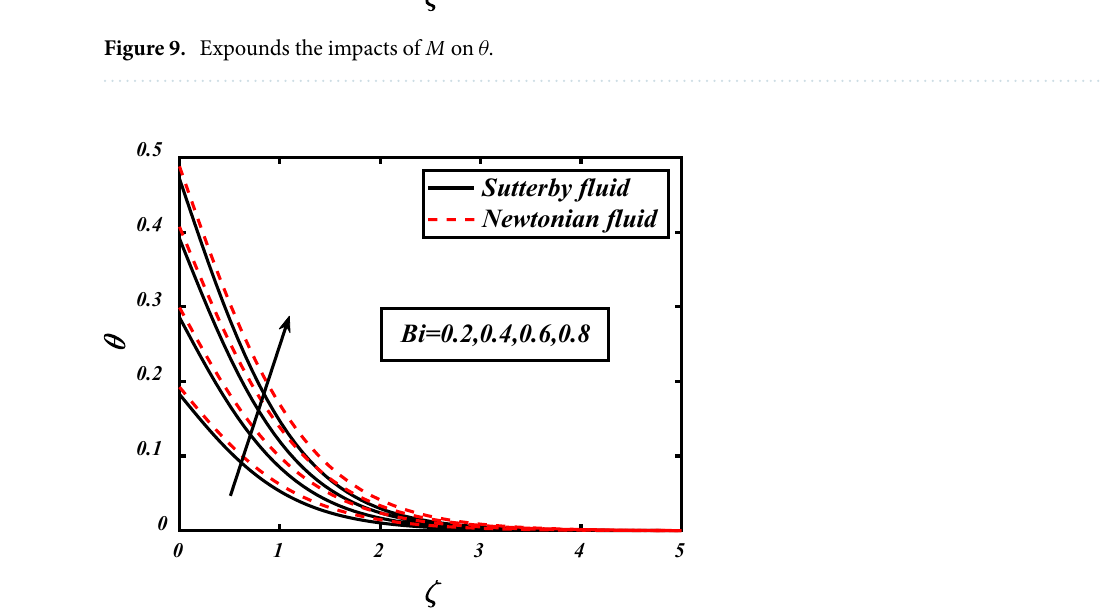
Figure 10. expounds the impacts of Bi on θ